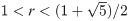
The Fan.(A) The Fan, Fn,m, consists of one hub and n ≥ 2 “blades”, with m ≥ 2 vertices per blade. Edge weights are as shown. The case n = m = 3 is pictured. (B) The ratio of effective versus actual population size, plotted against the hub-to-blade edge weight ϵ, for m = 2 vertices per blade. For n = 2 blades, the Fan is an amplifier of weak selection for 0 < ϵ < 1/3, but becomes a reducer in the ϵ → 0 limit. For n ≥ 3, the Fan is a transient amplifier for sufficiently small ϵ, including the ϵ → 0 limit. (C) Fixation probability for F4,2 (blue curve), plotted against mutant fitness r, in the ϵ → 0 limit, according to Eq (15). The orange curve shows the corresponding well-mixed population result, Eq (1), for comparison. Dotted lines show the corresponding weak-selection results (i.e. the linear approximation at r = 1), according to Eqs (4), (8), and (14). (D) In the n → ∞ limit, fixation probability is given by Eq (15), and the Fan is an amplifier for 1<r<(1+5)/2.